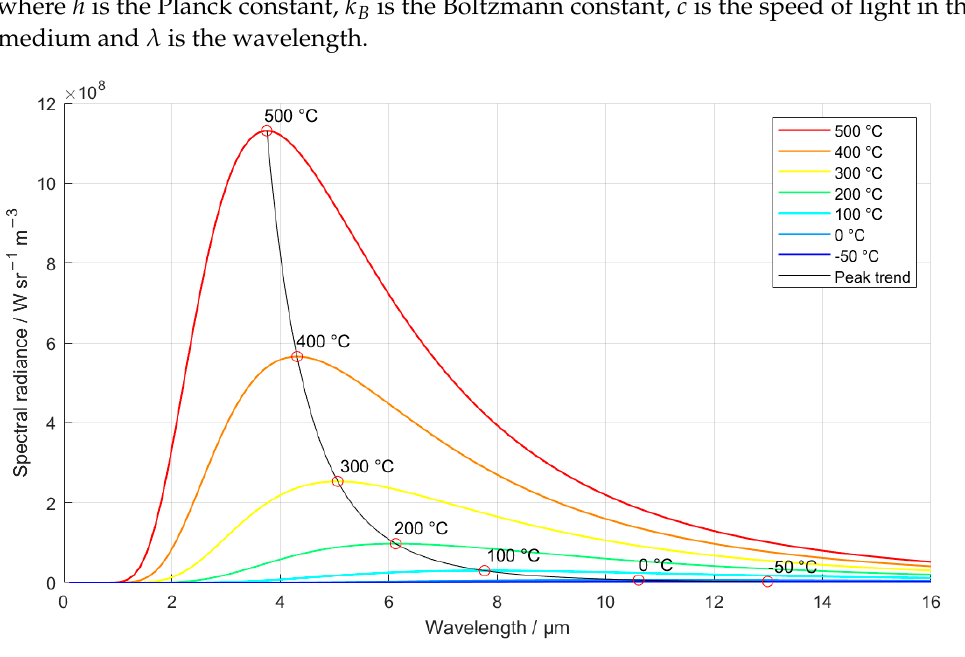
Figure 2. Spectral radiance emitted by the black body, according to Planck’s law (1). The actual emission of any real surface is the emission of the black body (2), spectrally reduced by the spectral emissivity of the surface.